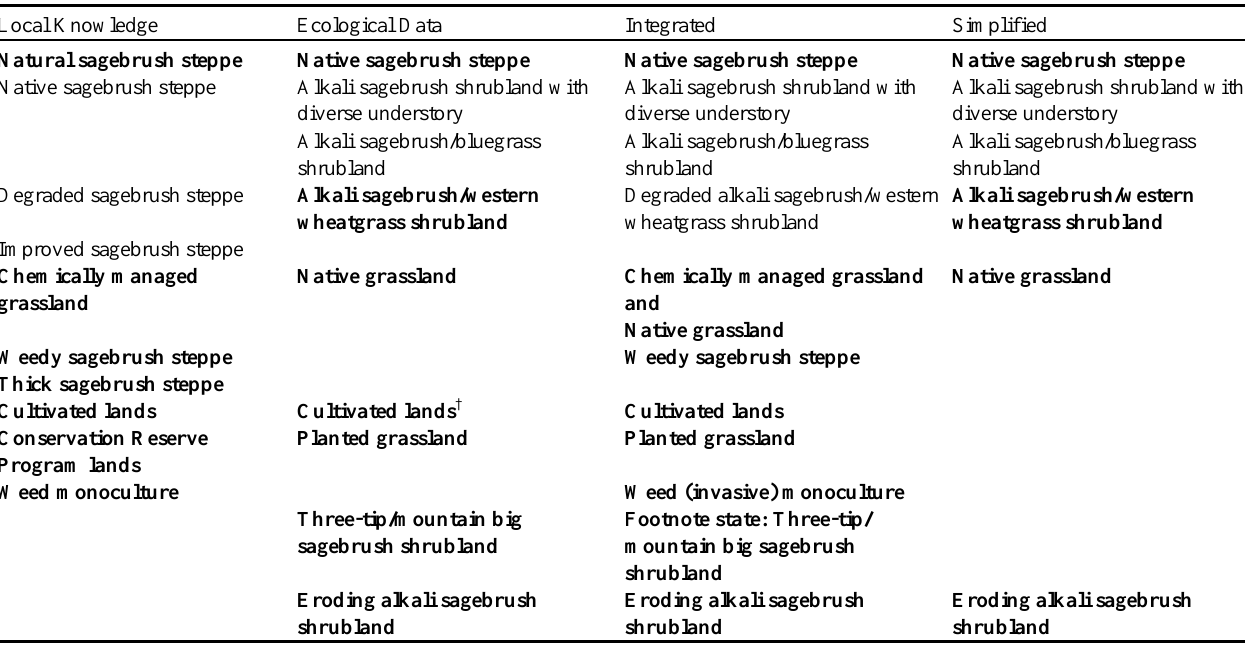
Table 1 . States (bold) and communities (plain text) of the Claypan ecological site, northwest Colorado, USA, drawn from a multidisciplinary modeling process (see Fig. 1). Similar states and communities from different modeling steps are on the same line. Many states and communities were identified at multiple modeling steps, and the Simplified model reflects states about which there was the most